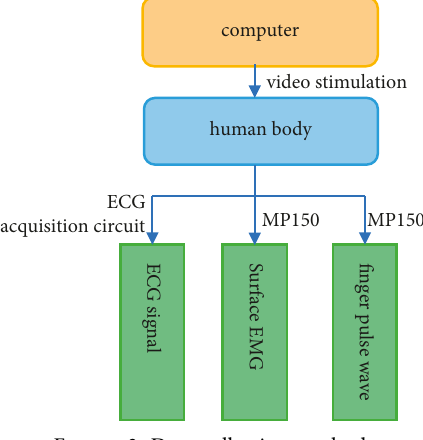
Figure 2: Data collection